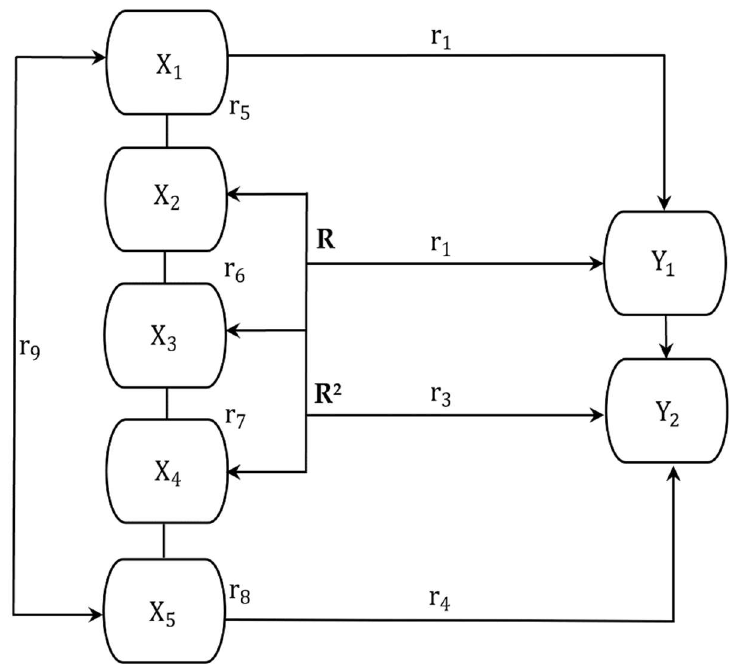
Figure 3. Model of multiple regression. Source: Authors’ elaboration.